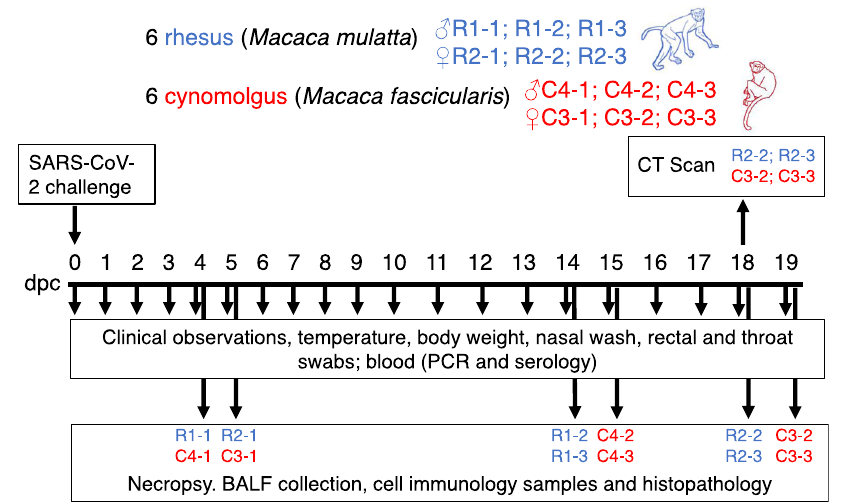
Fig. 1 Experimental study design. Rhesus and cynomolgus macaques were inoculated with severe acute respiratory syndrome coronavirus 2 (SARS-CoV- 2) and culled in groups at three time points (4/5; 14/15 and 18/19 dpc). Animals were monitored for clinical signs and blood/swab/tissue samples were taken for virology, immunology and pathology. CT scan imaging was carried out at 18